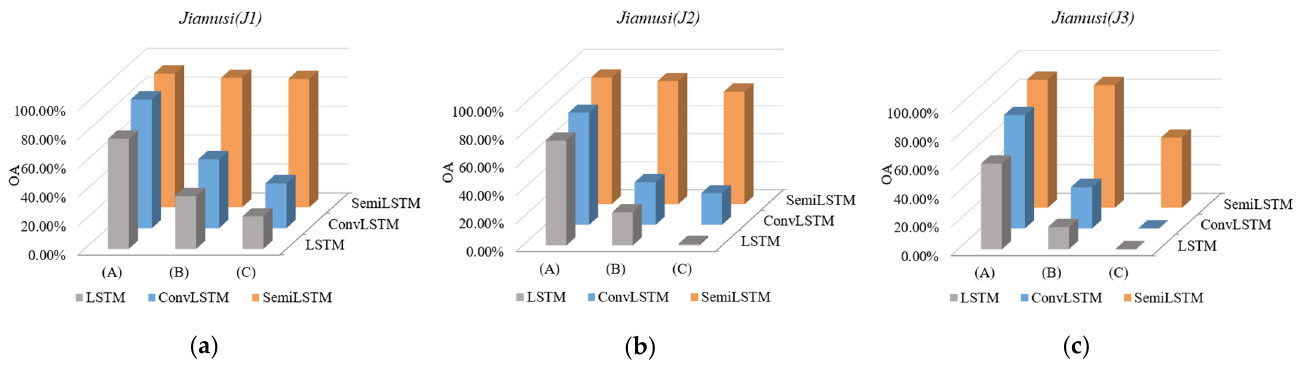
Figure 11. The OA results of time series subdata sets with different cloud coverage (where (A), (B) and (C) represent subdata sets containing low-cloud, less than 50%-cloud and thick cloud coverage respectively). ( a ) J1 ; ( b ) J2 ; ( c ) J3 .